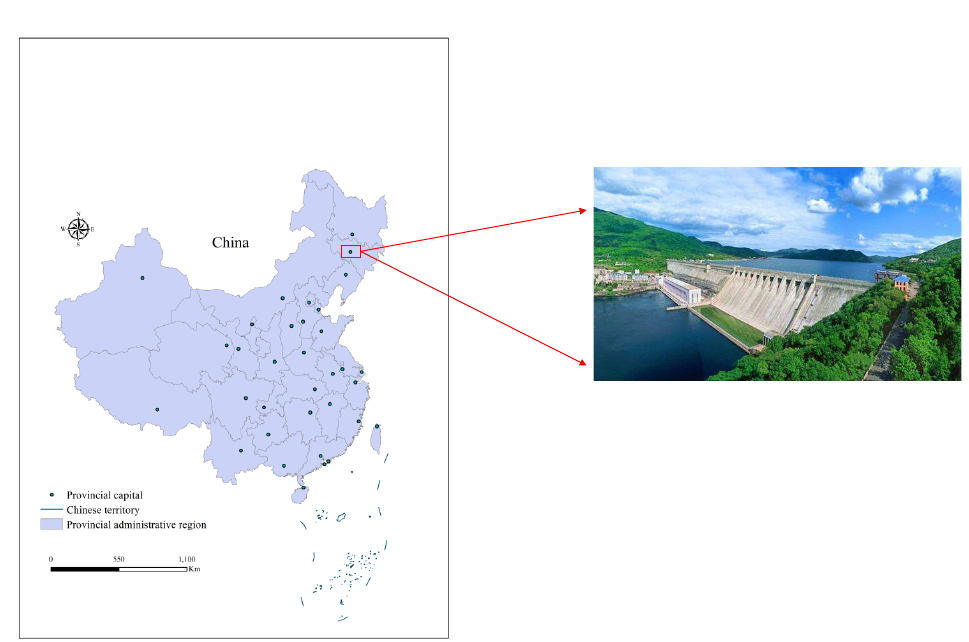
Figure 6. Geographic location map of FengMan Dam.